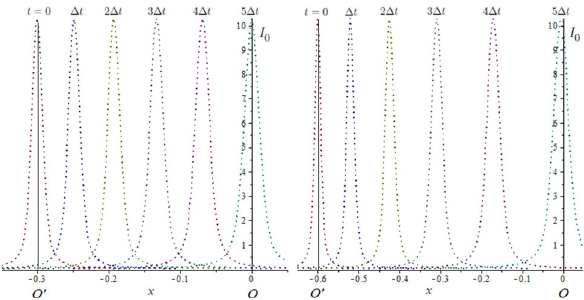
Fig. 2 Spacedispersionoftheprofilesof I 0 ( t , x ) oftheGaussianwave packet prepared in O (cid:8) (with a 3 = 0 . 005 and ¯ k 3 = 100) as observed by O at consecutive epochs. In the left panel d = 0 . 3 and (cid:6) t = 0 . 0713, while in the right panel d = 0 . 6 and (cid:6) t = 0 . 1832